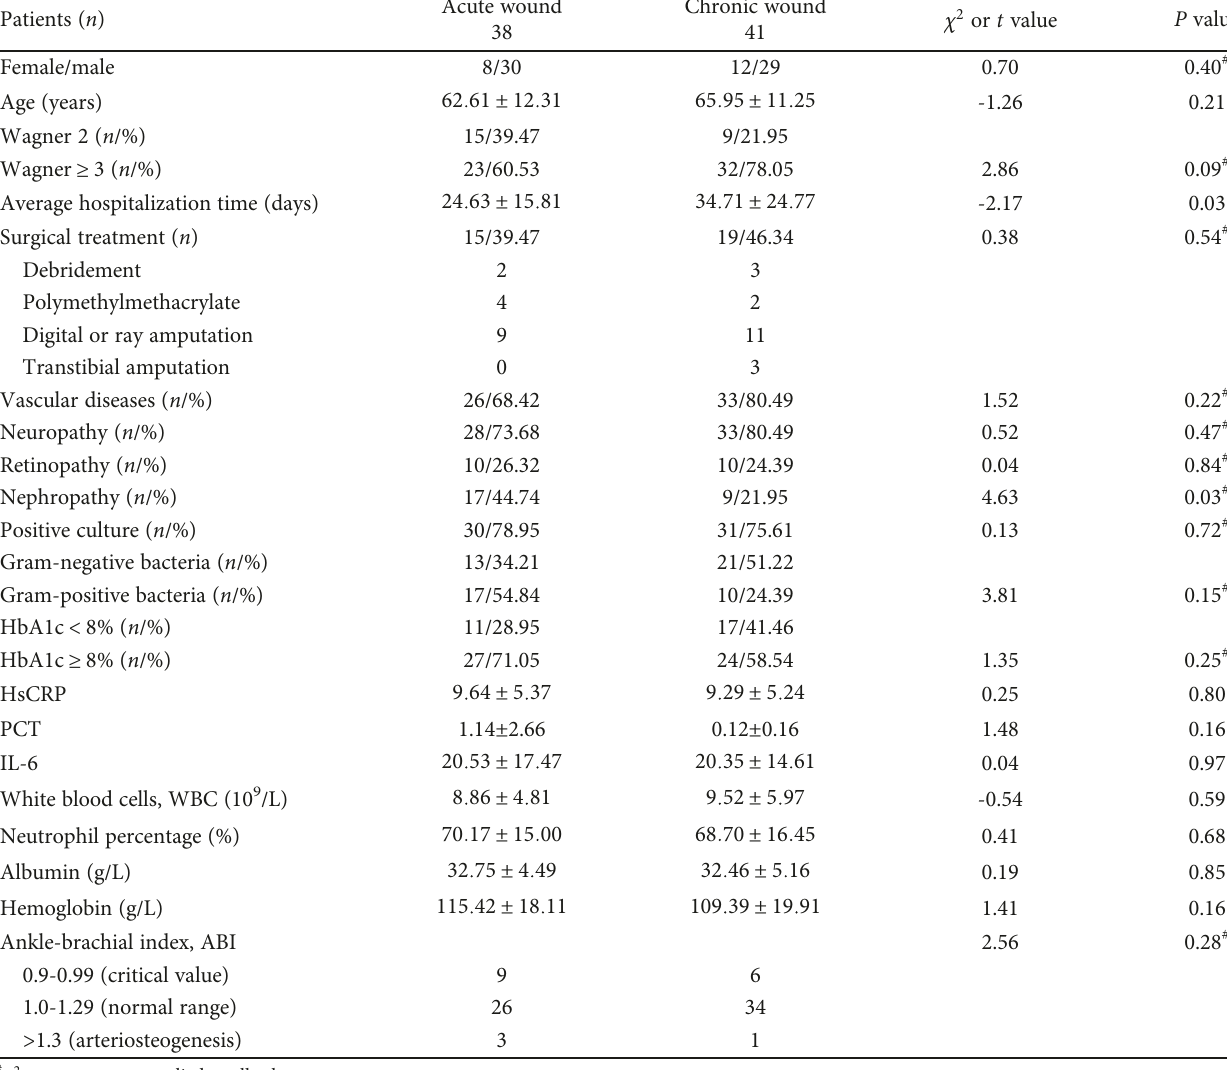
Table 1: Demographics and laboratory results of diabetic foot patient